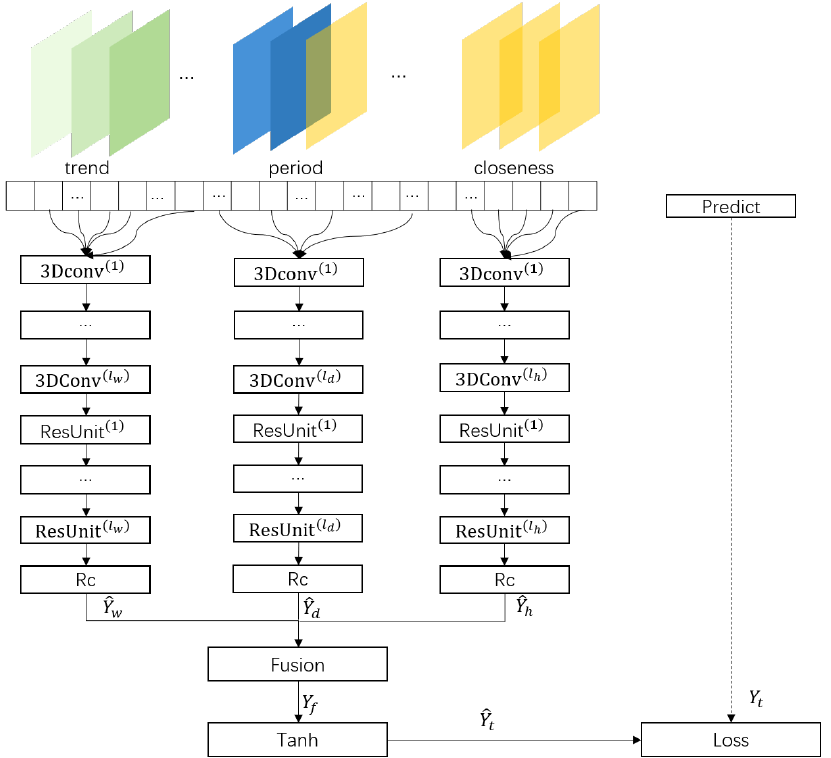
Figure 5. Improved ST-3DNet structure for crime prediction. 3D Conv, Resunit and Rc denote 3D Convolutional, residual unit and Recalibration block,